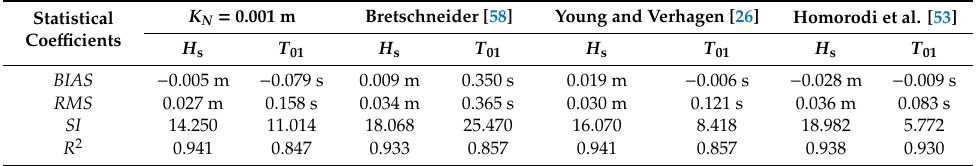
Figure 12. Correlation between the fully developed wave data measured in July 2005 and that given by: ( a1-2 ) the growth curve with K N = 0.001 m; ( b1-2 ) Bretschneider [58] formulation; ( c1-2 ) Young and Verhagen [26] formulation; ( d1-2 ) Homorodi et al. [53] bidimensional (2D) spectral application. Table 5. Coefficients related to wave heights and periods measured and computed referring to the July period.